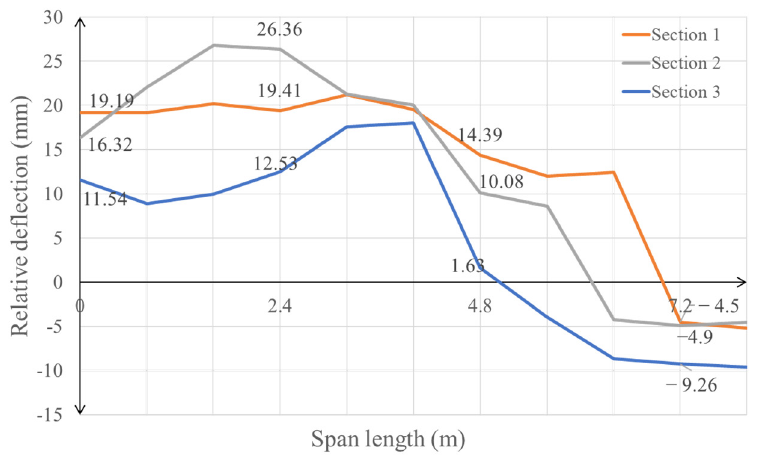
Figure 12. Relative deflection graph of the three sections.